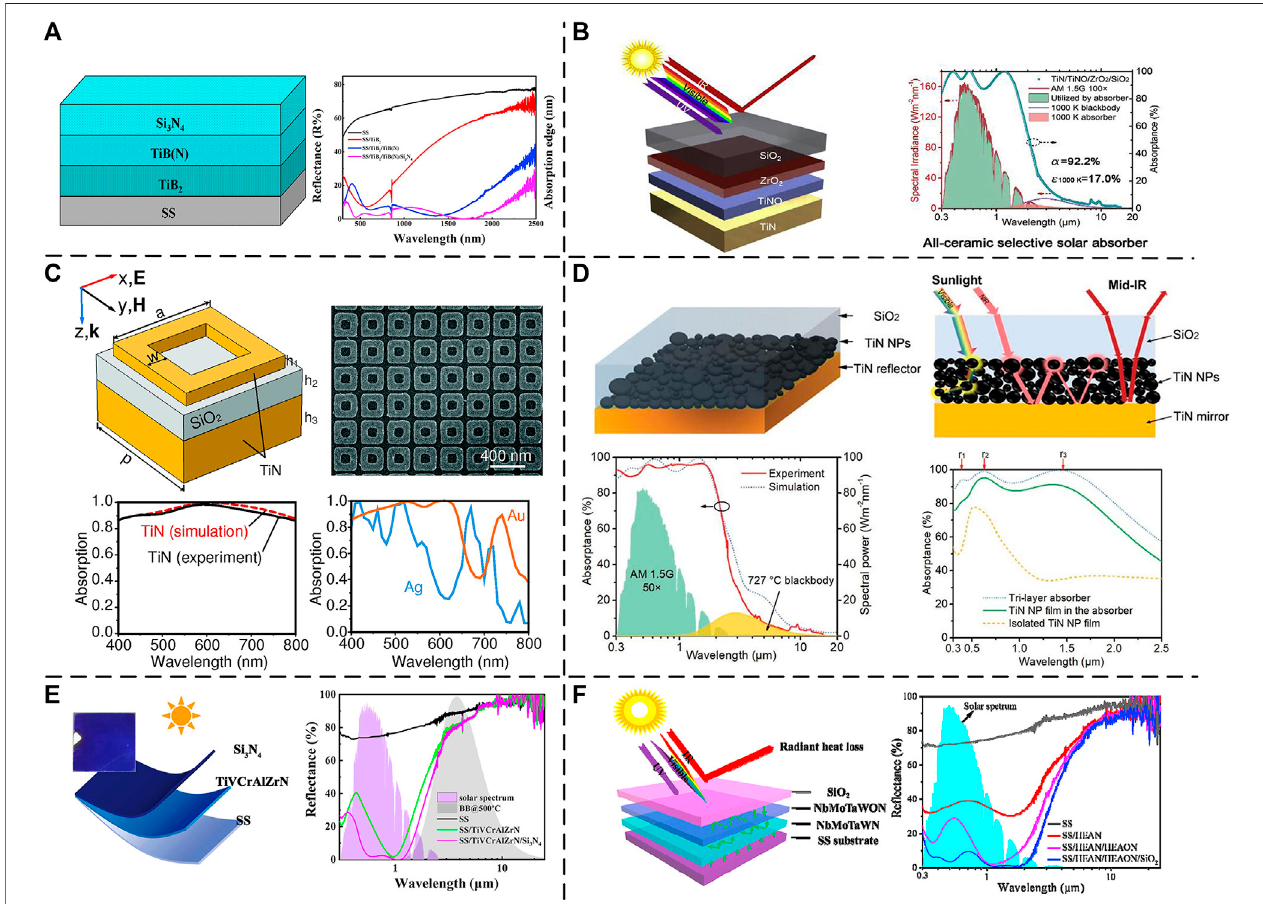
FIGURE 2 | Structure design and spectral selective performance of all-ceramic SSACs. (A) Gradient refractive index-designed TiB 2 /TiB(N)/Si 3 N 4 structure (Adapted from Dan et al., 2018). (B) Multilayer TiN/TiNO/ZrO 2 /SiO 2 structure (adapted from Li et al., 2019). (C) Multilayer TiN-based plasmonic metamaterial structure (adapted from Li et al., 2014). (D) Multilayer TiN/TiN NP/SiO 2 absorber (adapted from Li et al., 2021). (E) High-entropy ceramic-based TiVCrAlZrN/Si 3 N 4 absorber (adapted from He et al., 2021a). (F) Multilayer NbMoTaWN/NbMoTaWON/SiO 2 structure (adapted from Yu et al., 2021).